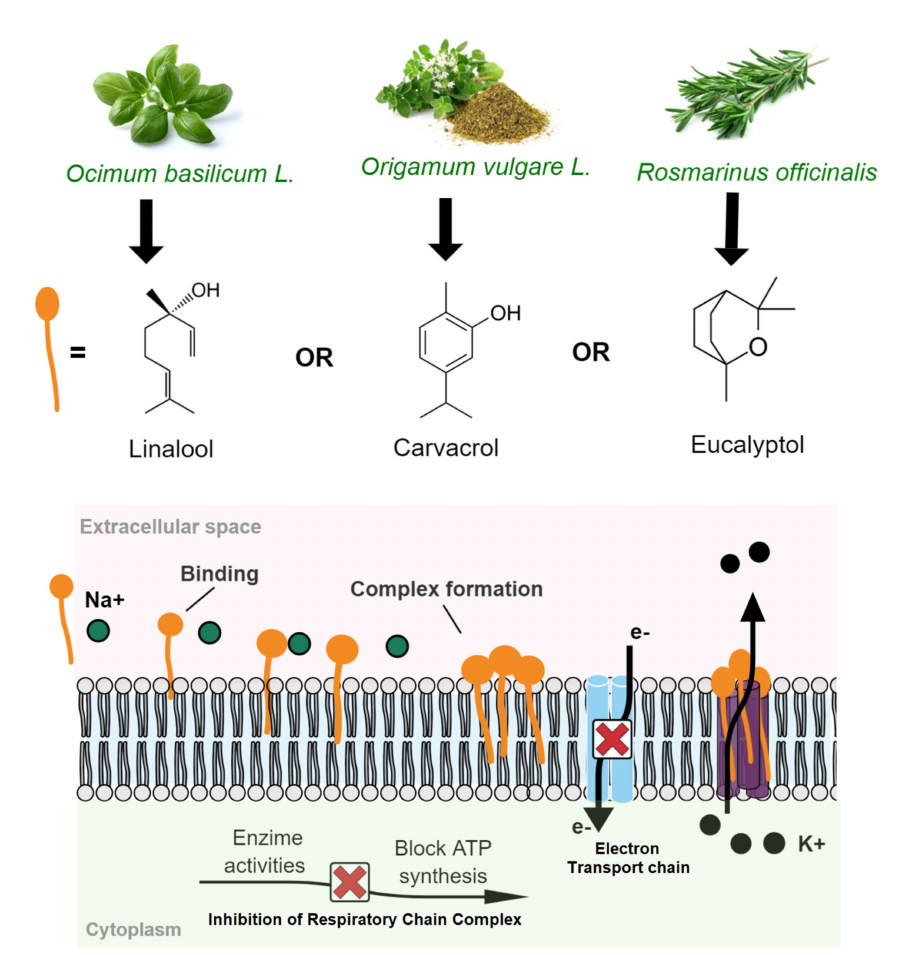
Figure 3. Antimicrobial action triggered by monoterpenoid compounds from basil, oregano, and rosemary essential oils: damaging cell membrane integrity and inhibiting a mitochondrial respiratory chain